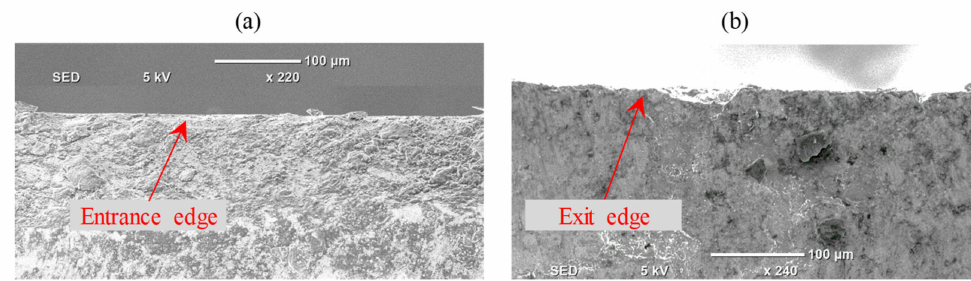
Figure 12. A comparison between the entrance and exit edge chipping ( a ) entrance edge chipping, ( b ) exit edge chipping.